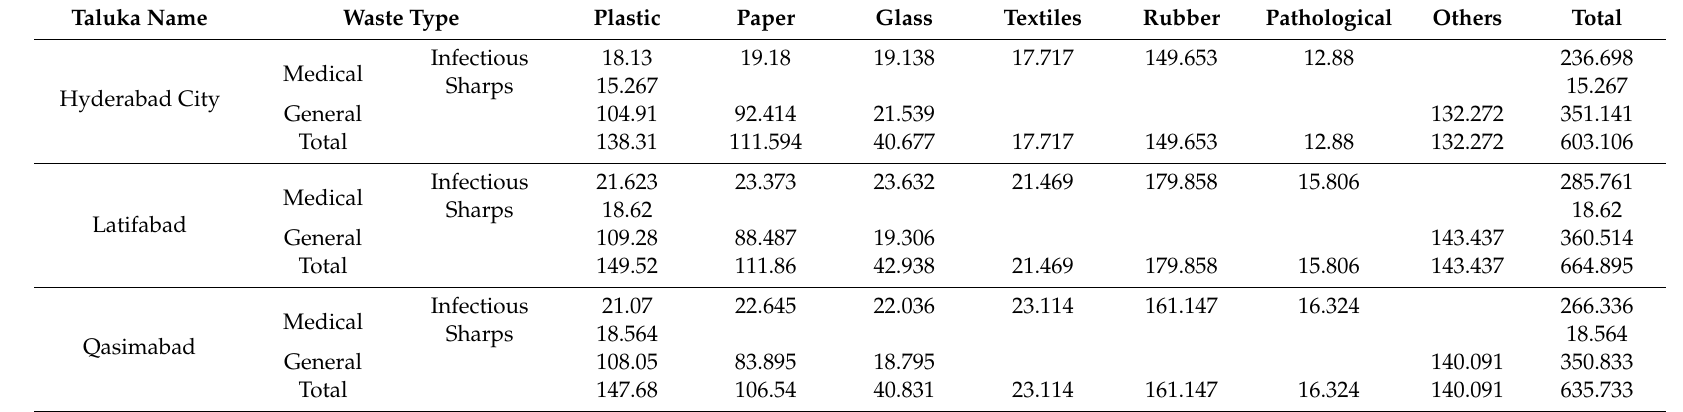
Table 1. Waste generation data of small clinics (all units